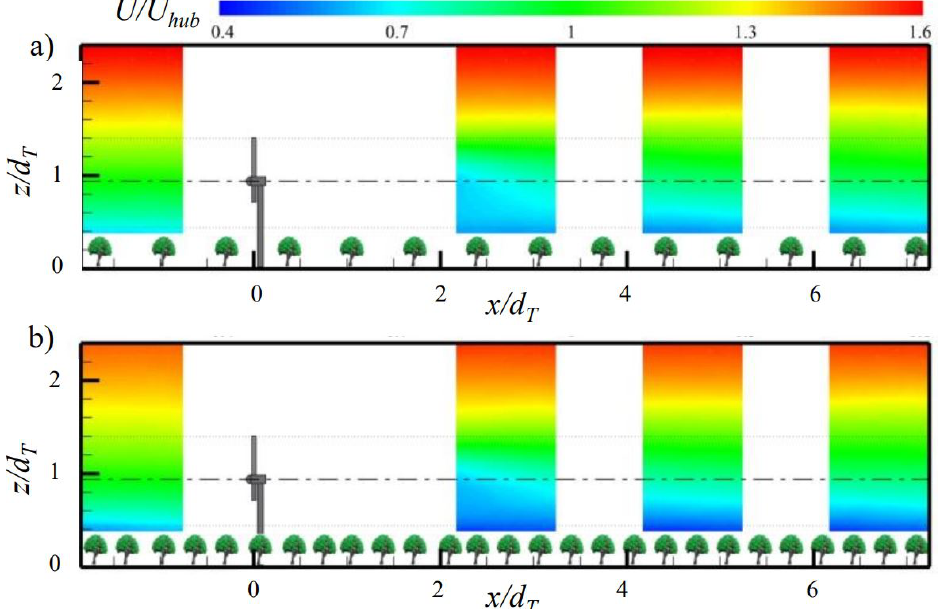
Figure 4. Time-averaged streamwise velocity distributions, U ( x , y = 0, z ) / U hub , above the ( a ) intermedi- ate and ( b ) dense canopies. The horizontal lines indicate the location of the hub, top and bottom tips of the